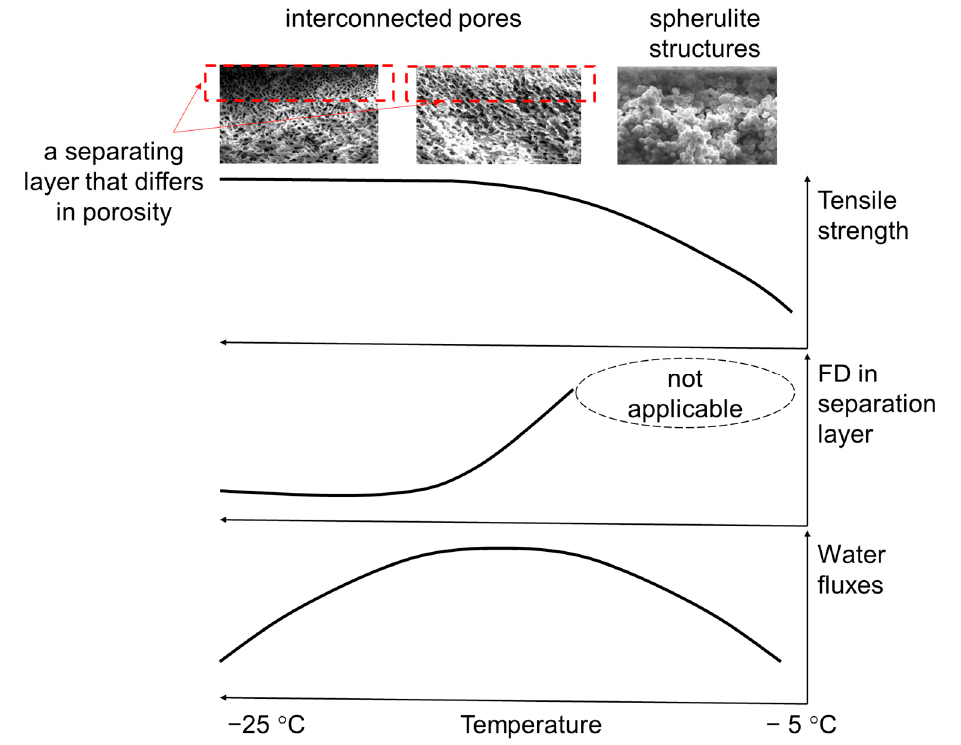
Figure 8. Scheme explaining the correlation between the properties of membranes prepared at different freezing temperatures and their pore structure.